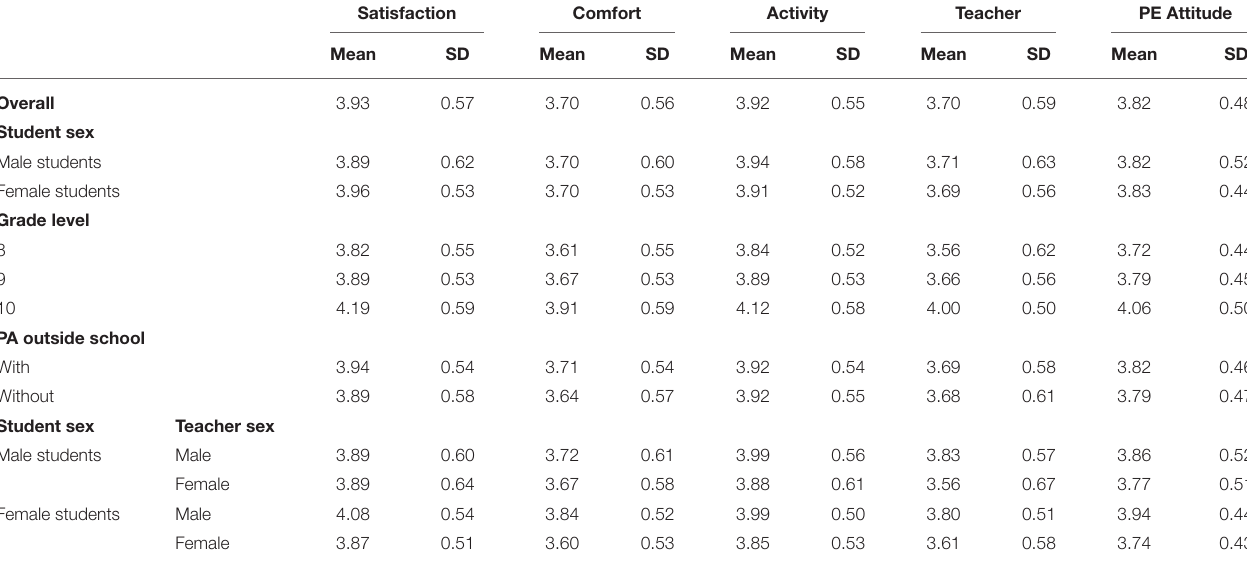
TABLE 1 | Overall PE attitude and dimensions of PE scores based on student sex, teacher, sex, grade level, and physical activity outside school. Satisfaction Comfort Activity